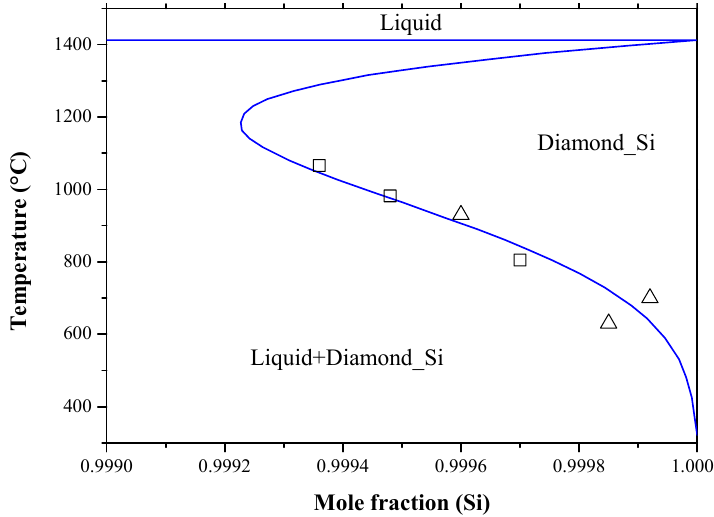
Figure 19. Magnified part of the calculated Ga-Si phase diagram [185]; □ : [118]; Δ : [85].